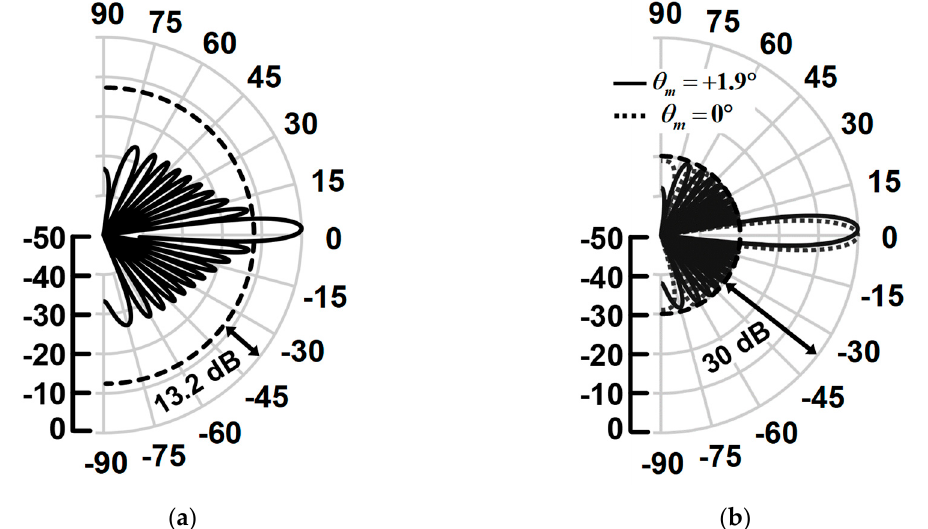
Figure 7. Far-field radiation patterns of 21-element OPA with ( a ) uniform amplitude distribution ( + 1.9 ◦ direction), ( b ) Taylor window function profile ( + 1.9 ◦ and 0 ◦ directions). θ m is the steering angle.